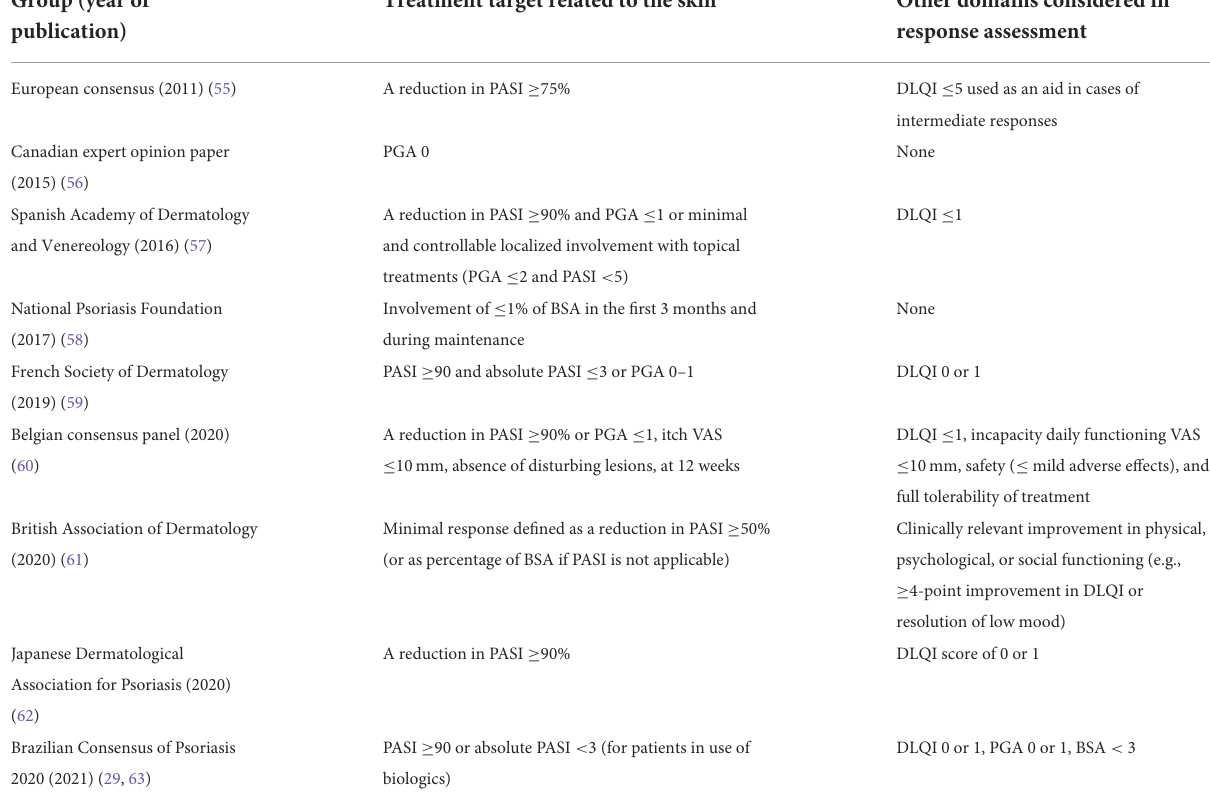
TABLE 1 Published proposed targets in